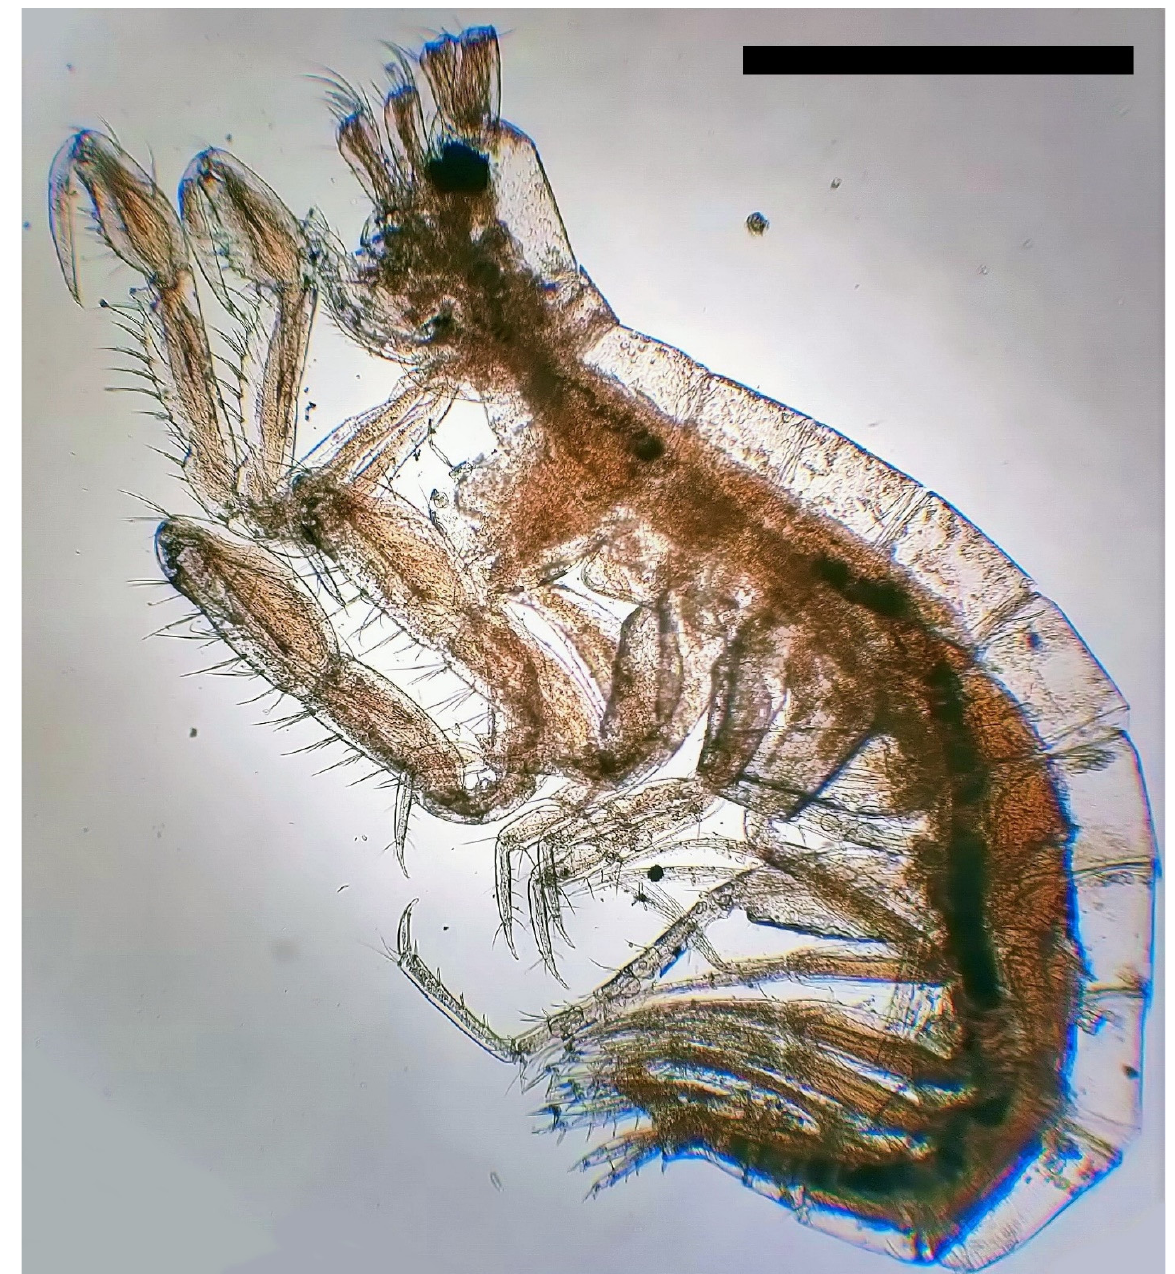
Figure 3. Megamphosus katagani : lateral view of a male specimen (antennae broken off). Scale bar: 1 mm. Photo credit: Emanuele Mancini.